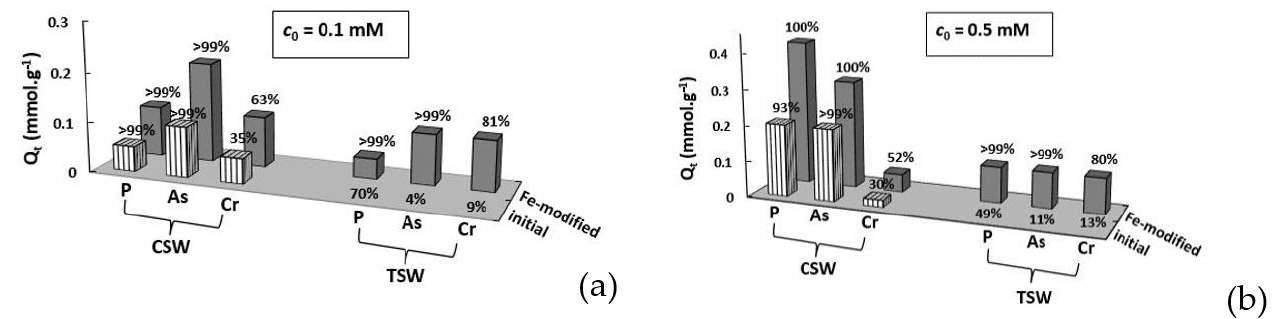
Figure 5. Theoretical adsorption capacities Q t of AsO 4 3− , PO 4 3− and CrO 4 2− adsorption on original (CSW and TSW) and Fe-modified (CSW Fe and TSW Fe ) sorbents at initial concentration c 0 of 0.1 mmol · L − 1 ( a ) and 0.5 mmol · L − 1 ( b ). Percentages above the bars indicate maximum adsorption efficiency.